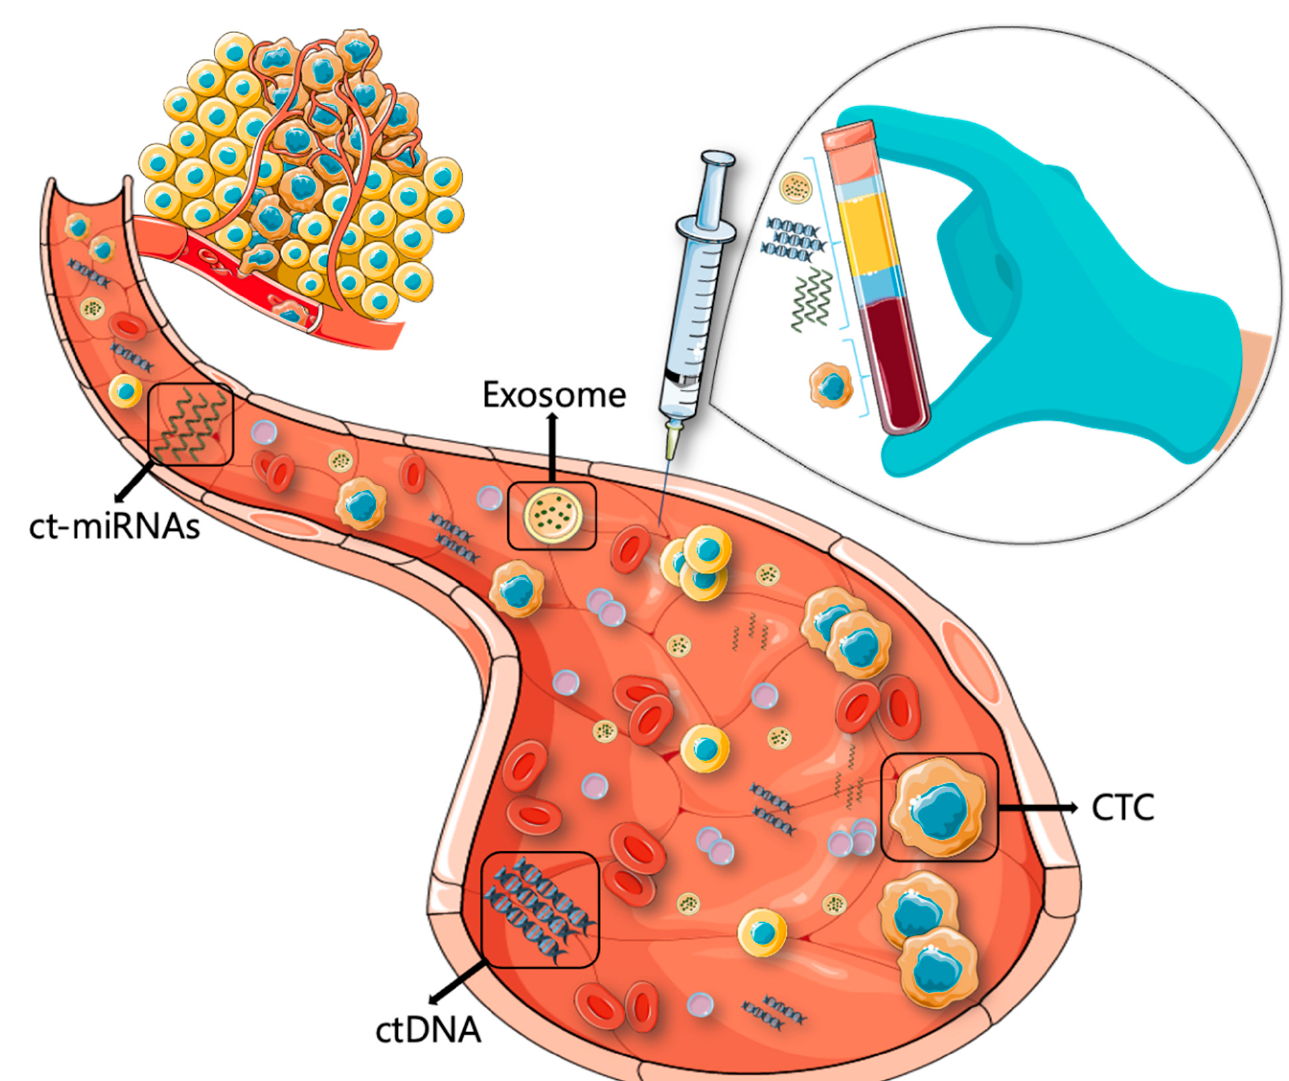
Figure 1. A schematic view of liquid biopsy. Blood collected from cancer patients contains circulating tumor cells (CTCs), circulating tumor DNA (ctDNA), exosomes, and circulating tumor microRNA (ct-miRNA). These biomarkers could provide real-time information on tumor progression, prognosis, and treatment response.